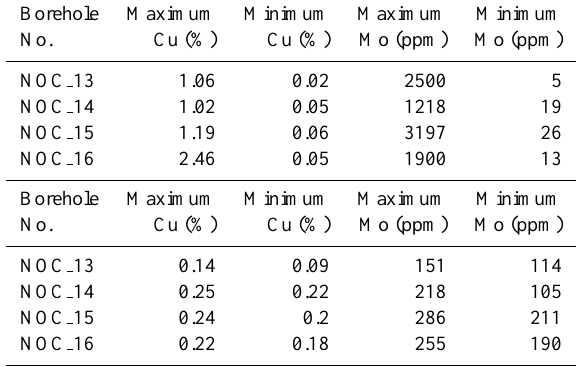
Table 3. Statistical parameters of Cu and Mo in NOC 13, NOC 14, NOC 15 and NOC 16 drilled boreholes in Nowchun deposit.